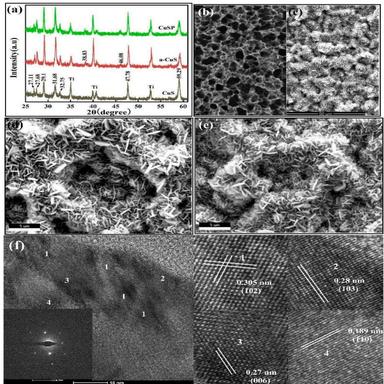
XRD patterns of CuS, a-CuS, and CuSP (a), FE-SEM patterns of Ti substrate (b), Ti/CuS (c, d) and Ti/CuSP (e), and HFTEM images and SAED of CuSP (f).